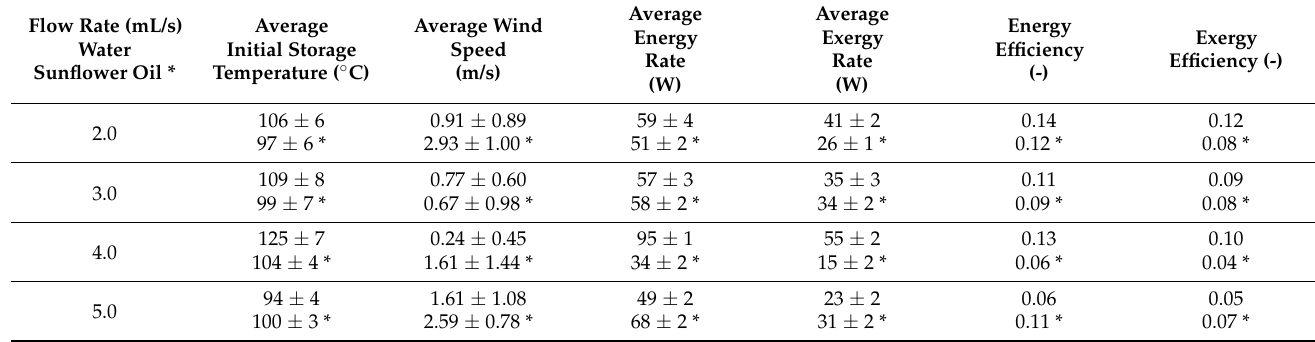
Table 3. Effect of the flow rate on the energetic and exergetic of water and sunflower oil loads during discharging cycles with a load of 0.5